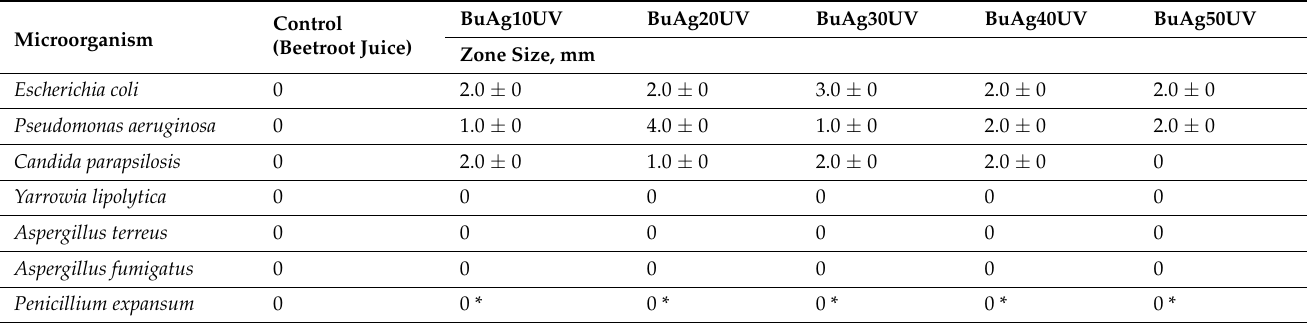
Table 1. Antimicrobial activity of the gelatin films with silver nanoparticles against microorganisms. Microorganism